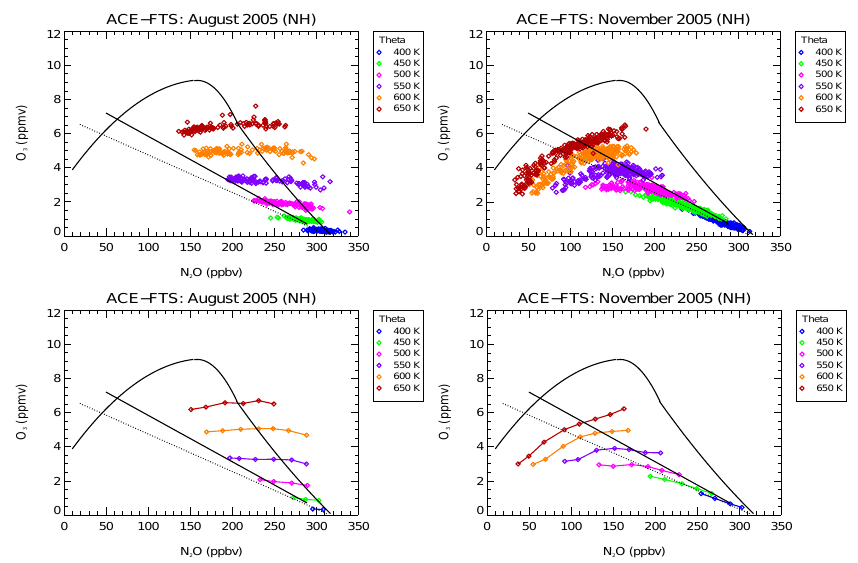
Fig. 1. N 2 O versus O 3 for August and November 2005 derived from ACE-FTS observations (NH). Top: N 2 O/O 3 correlation separated into potential temperature bins from 400 ± 25K to 650 ± 25K given by the colour coding. Bottom: O 3 /N 2 O correlation after the averaging over 20ppbv N 2 O has been applied within the potential temperature bins. Additionally, the May mid-latitude (ATMOS Shuttle 1985, solid line), April high latitude (ATMOS Shuttle 1993, dashed line), and November tropics (ATMOS Shuttle 1994, solid curve) reference curves are shown (Proffitt et al., 1990; Michelsen et al., 1998b).